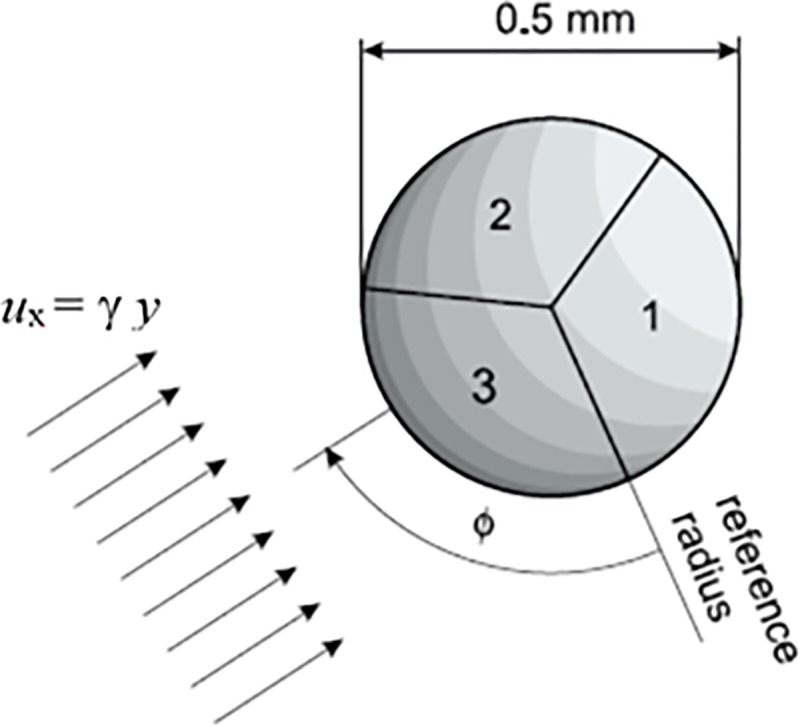
Front view of ideal three-segment probe with current density.